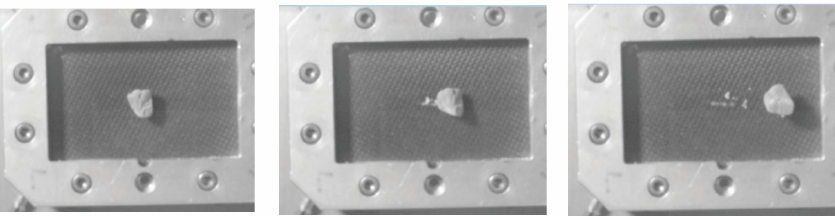
Figure 20. Sample 5, sharp gravel, CF + Kevlar, 2.8 J, showing the initial ( left ), intermediate ( centre ), and gravel detachment stages ( right ).